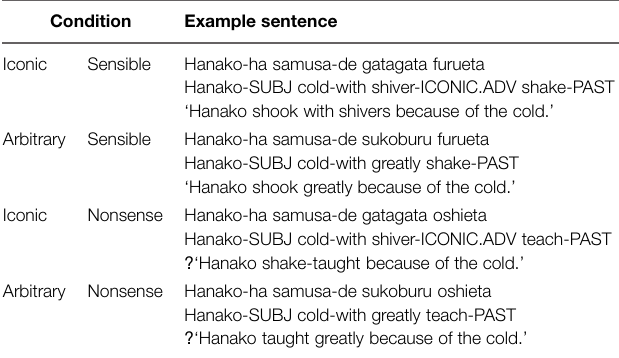
TABLE 1 | Experimental conditions for one set of four example stimuli sentences.